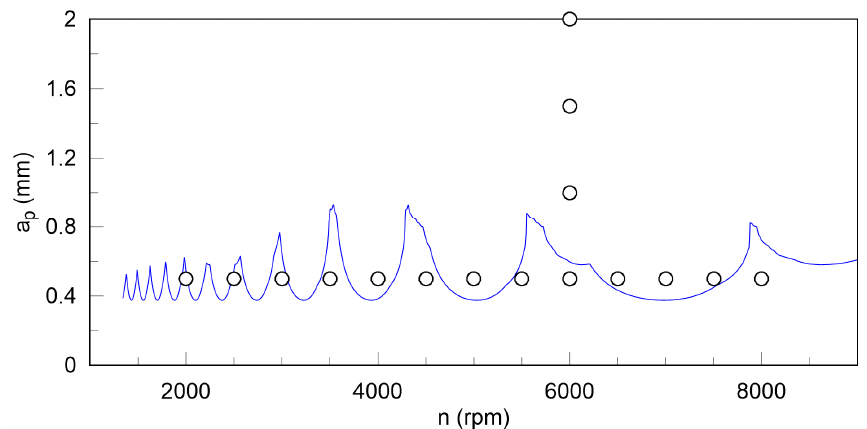
Figure 3. Theoretical stability lobe diagram (SLD, blue line) determined based on CutPro9 software together with proposed points of milling tests.